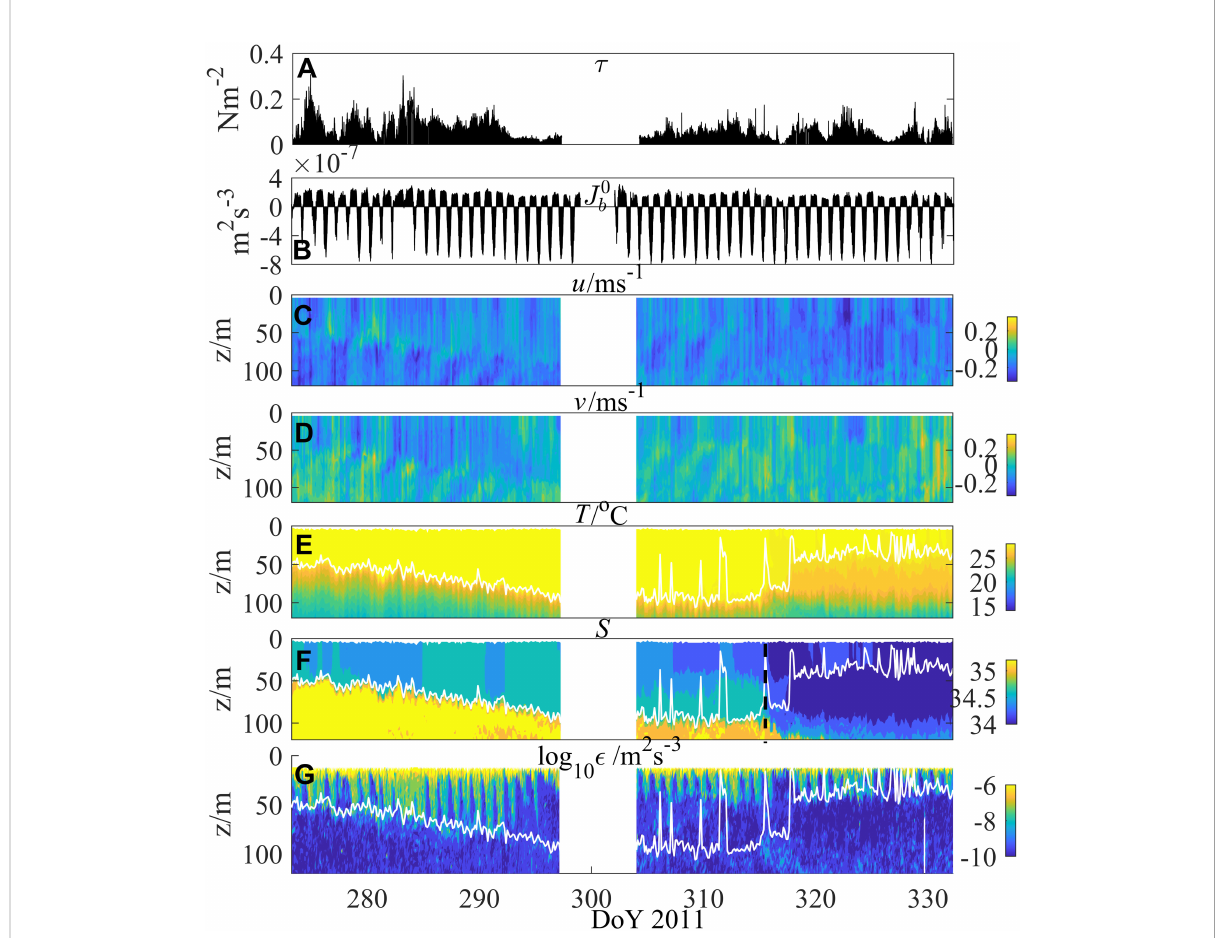
FIGURE 2 Time series of (A) wind stress, (B) surface buoyancy fl ux, (C) zonal current, (D) meridional current, (E) temperature, (F) salinity, and (G) TKE dissipation rate at the observation site. The white curves denote the base of the mixed layer. The black dashed line in (F) indicates that the data after DoY 315 (November 11) were not used due to the intrusion of a low-salinity water mass in the upper